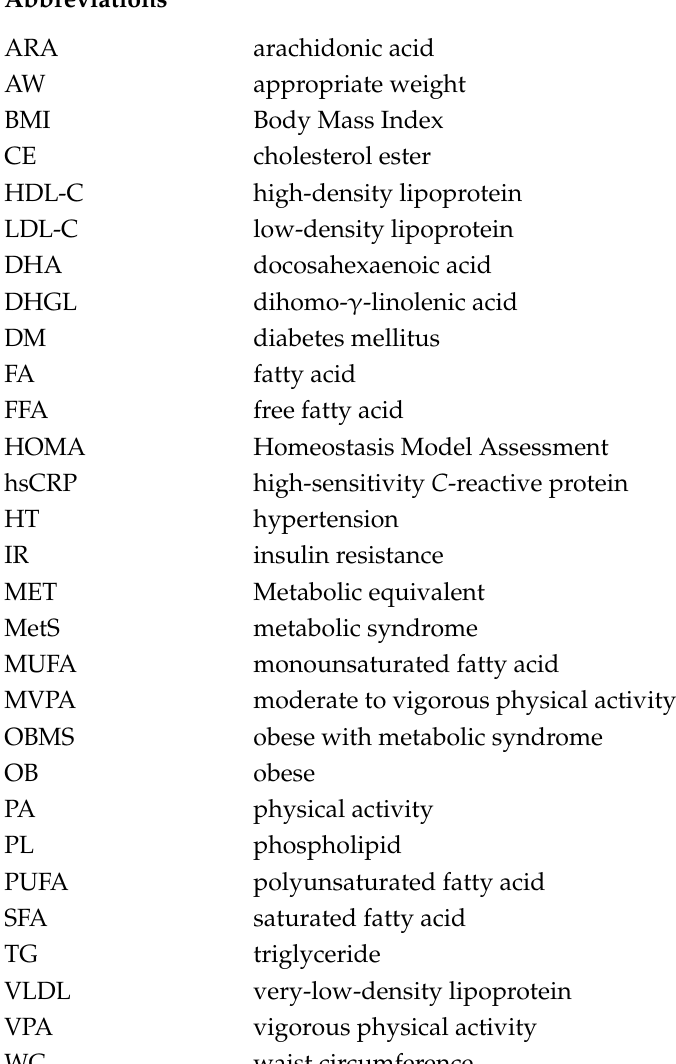
Table S1 Correlations between fatty acids of triglycerides, phospholipids, free fatty acids fractions, and cardiovascular risk factors in